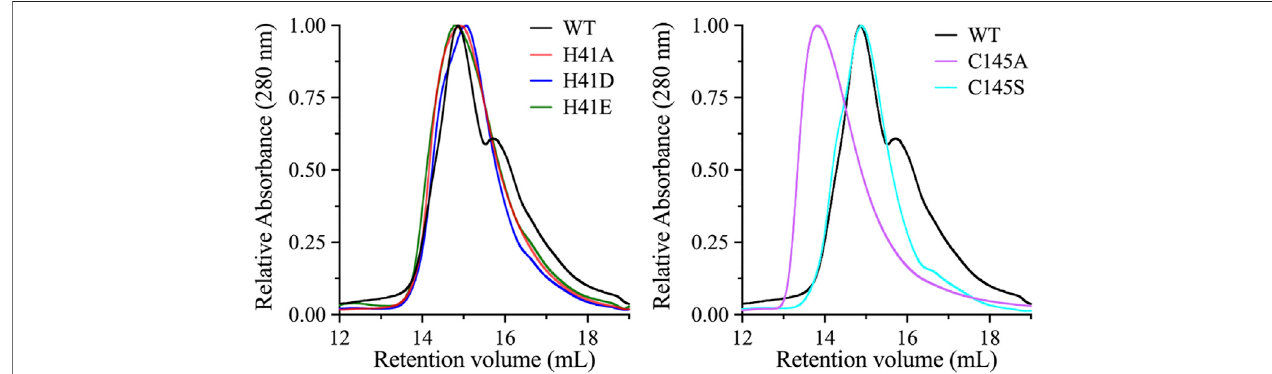
FIGURE 3 | Oligomeric state analysis of 3CLpro variants. Size-exclusion chromatography pro fi les of the WT and its variants. Highly concentrated protein samples (180 μ M) were injected onto the size-exclusion column (Superdex 200 increase 10/300 GL). The WT exhibited an early large peak corresponding to the dimeric state, with a late smaller peak corresponding to the monomeric state. The chromatographic peaks of His41 variants were different from those of the WT enzyme, with a single dominant peak of dimeric-state protein. Similarly, the chromatographic peak of the C145A variant exhibited a single peak that aligned with the dimeric peak of the WT enzyme. However, the single chromatographic peak ofthe C145S variant wasshifted toan earlier retention volume, which represents ahigher oligomeric state than the dimeric state of the WT